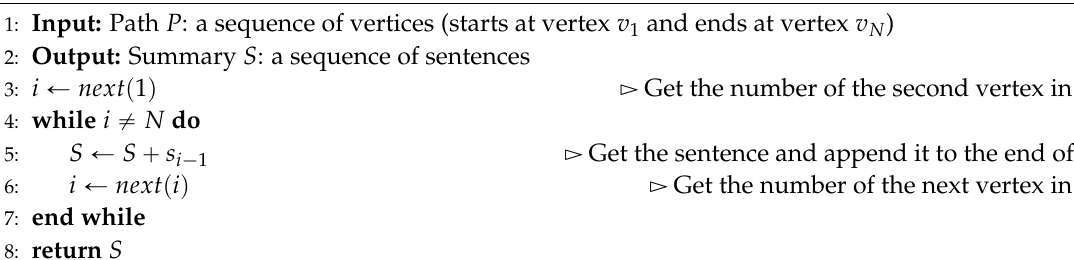
Algorithm 2 Decoding of a solution to OP into a solution to